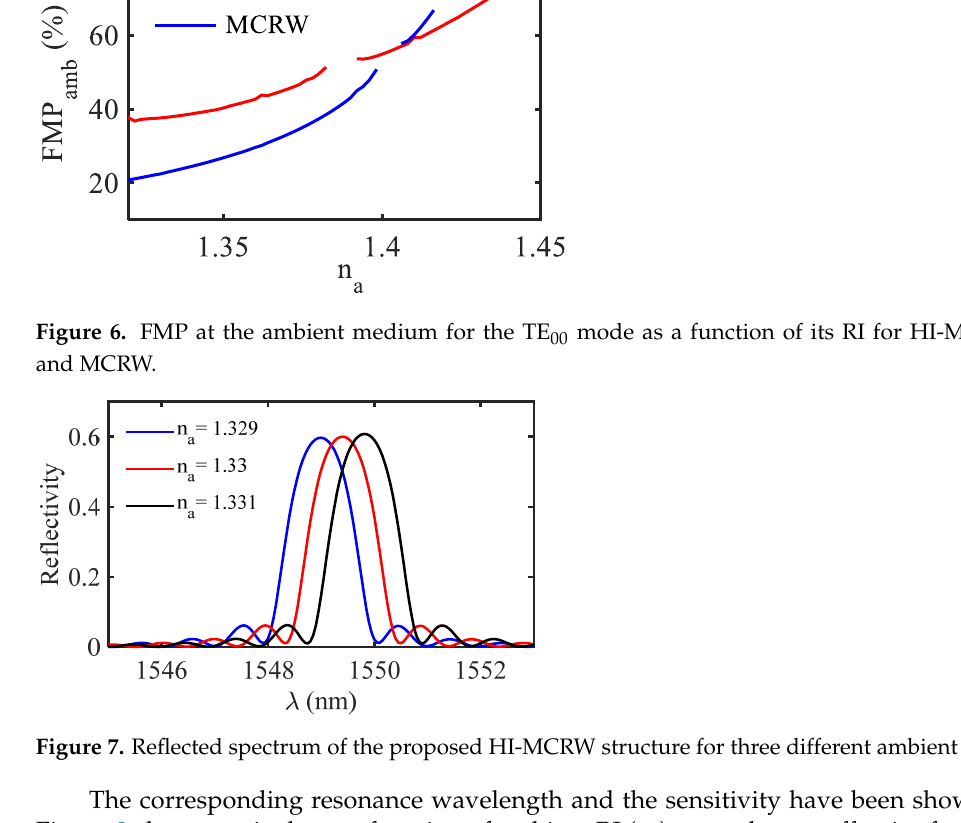
Figure 6. FMP at the ambient medium for the TE 00 mode as a function of its RI for HI-MCRW and MCRW.